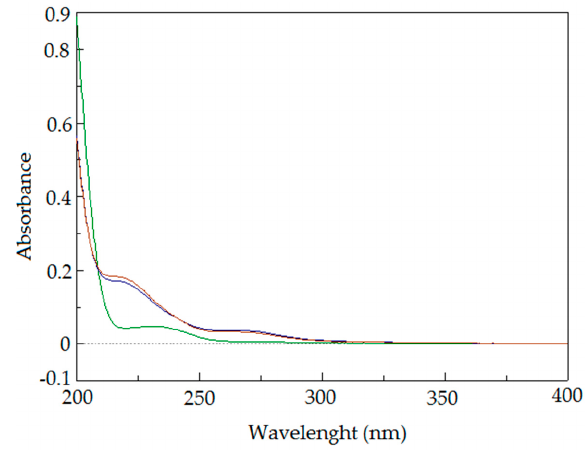
Figure 7. UV-VIS spectra of modified oils A_CO 2 (blue line) and A_O 2 (red line) superimposed on the spectrum of raw Crambe abyssinica oil A (green